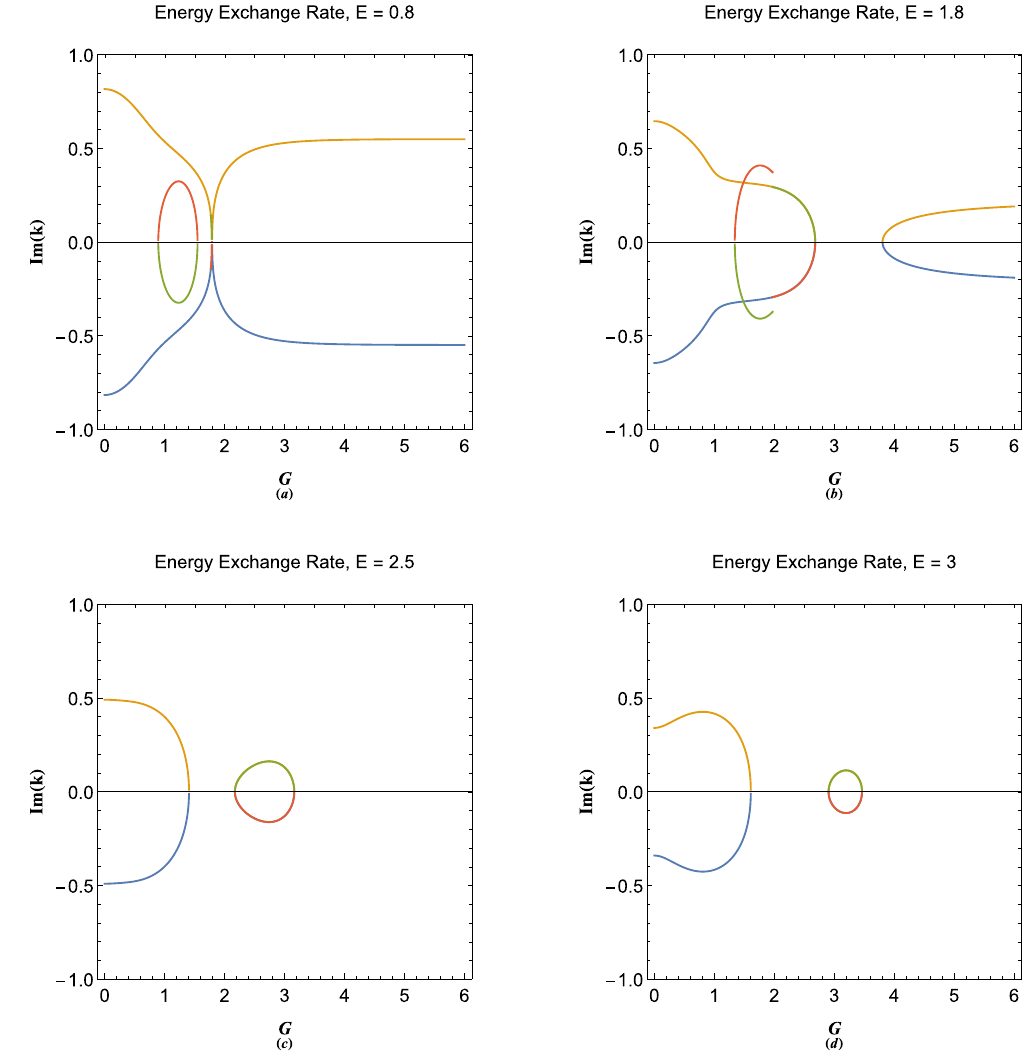
Figure 6. Variations in imaginary parts of plasmon excitation wavenumbers in plasmonic crystal in terms of reciprocal lattice vector G at orbital ( a ) E are small wavelength particle-like and negative large wavelength wave-like plasmon excitation wavenumbers corresponding to each energy